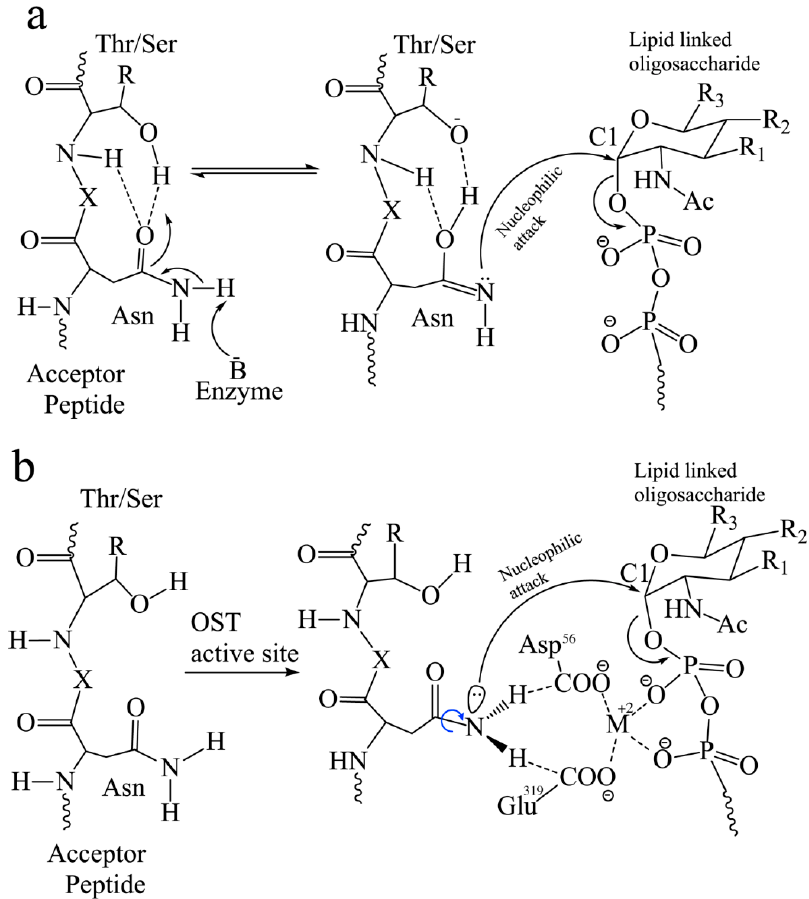
Figure 2. Possible reaction schemes of N -linked glycosylation showing nucleophilic attack by sidechain amide of the acceptor asparagine residue yielding a glycosylated peptide. ( a ) Mechanism of formation of an imidate tautomer, a competent nucleophile followed by nucleophilic attack on C1 of the dolichol-linked oligosaccharide. ( b ) Twisted amide activation mechanism for glycosylation of the acceptor peptide. The amide group forms H- bonds (dashed lines) with Glu319 and Asp56 residues leading to rotation of the C-N bond (indicated by the blue arrow) in bacterial PglB. These residues (Asp56 and Glu319) form H-bonds with the catalytic divalent metal ion. R 1 is OH in eukaryotes, and oligosaccharyl in bacteria. R 2 is oligosaccharyl in eukaryotes and NHAc in bacteria. R 3 is CH 2 OH in eukaryotes and CH 3 in bacteria [58]. X is any amino acid except proline.